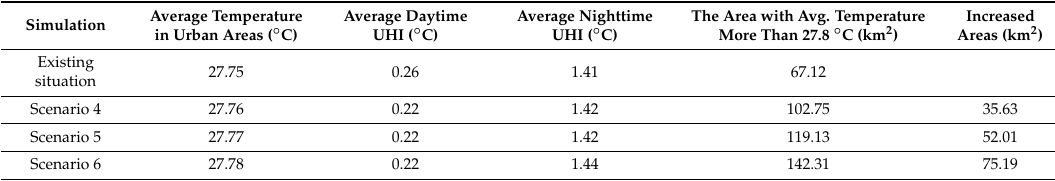
Table 3. Model’s outputs for urban expansion